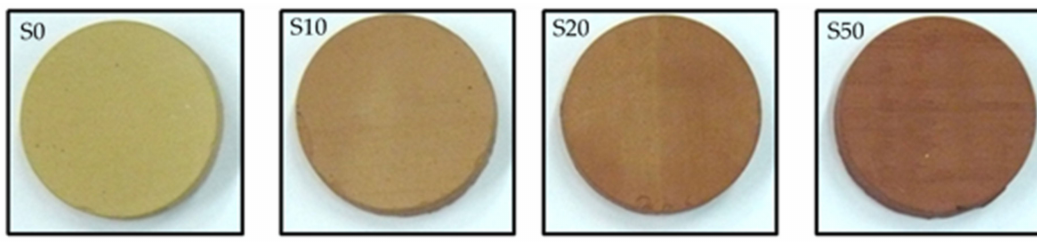
Figure 1. Fired (1000 ◦ C) ceramic substrates with di ff erent amounts of ferroalumina. S0 (0 wt% FA), S10 (10 wt% FA), S20 (20 wt%